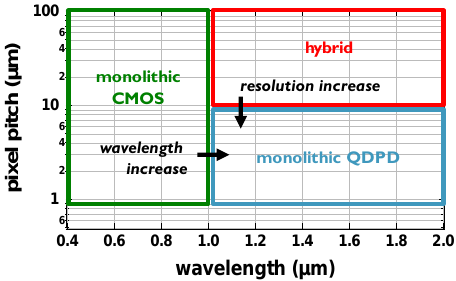
Figure 2. Positioning of a QDPD-based image sensor: higher wavelength than monolithic Si and higher resolution than hybrid alternatives.